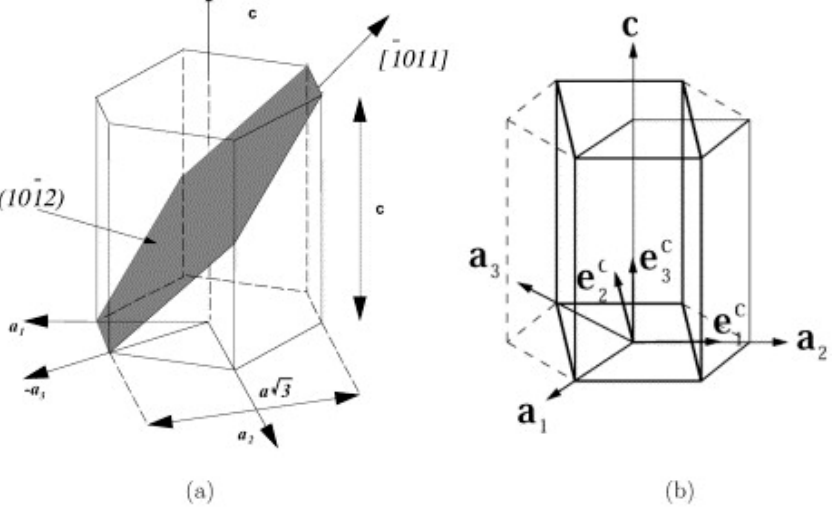
(cid:8) (cid:9) (cid:104) 1012 1011 (cid:105) in Mg and its alloys. (cid:12) (cid:8) (cid:9) e c (After Staroselsky (cid:12) i = 1,2,3 i